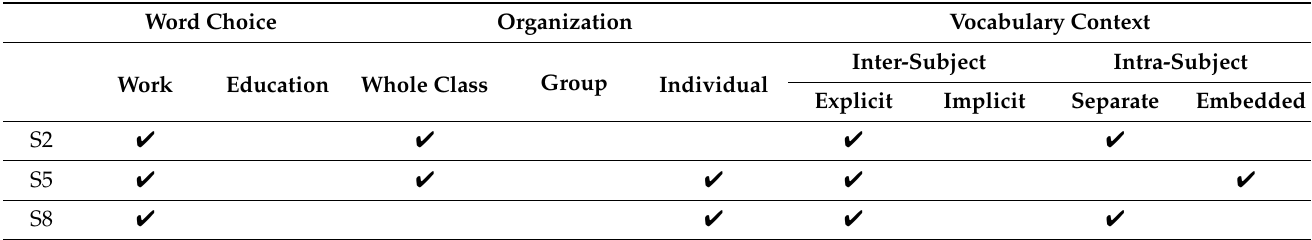
Table 3. Details about the observations described as